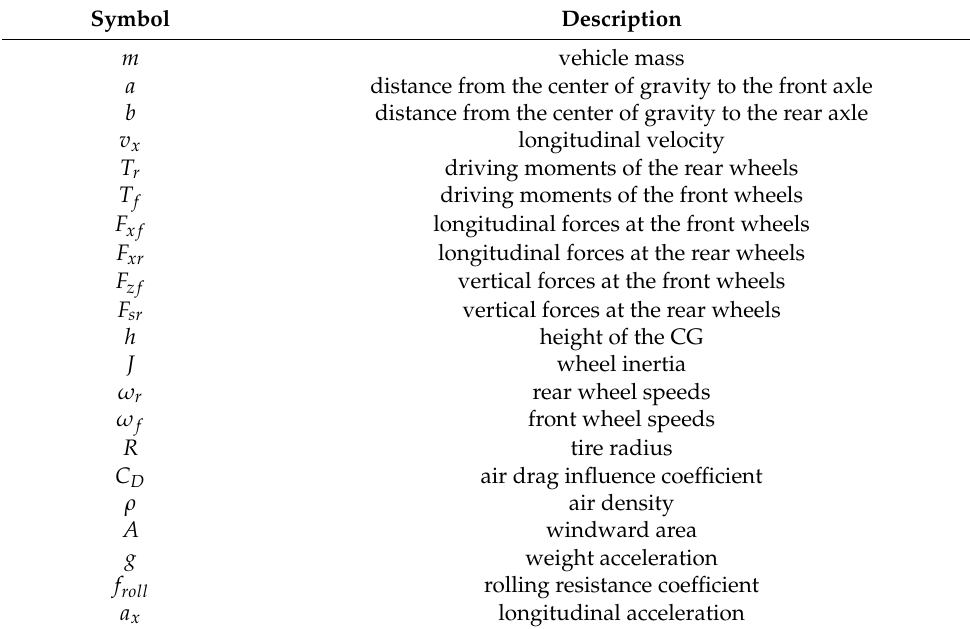
Table 1. The parameters of the longitudinal motion